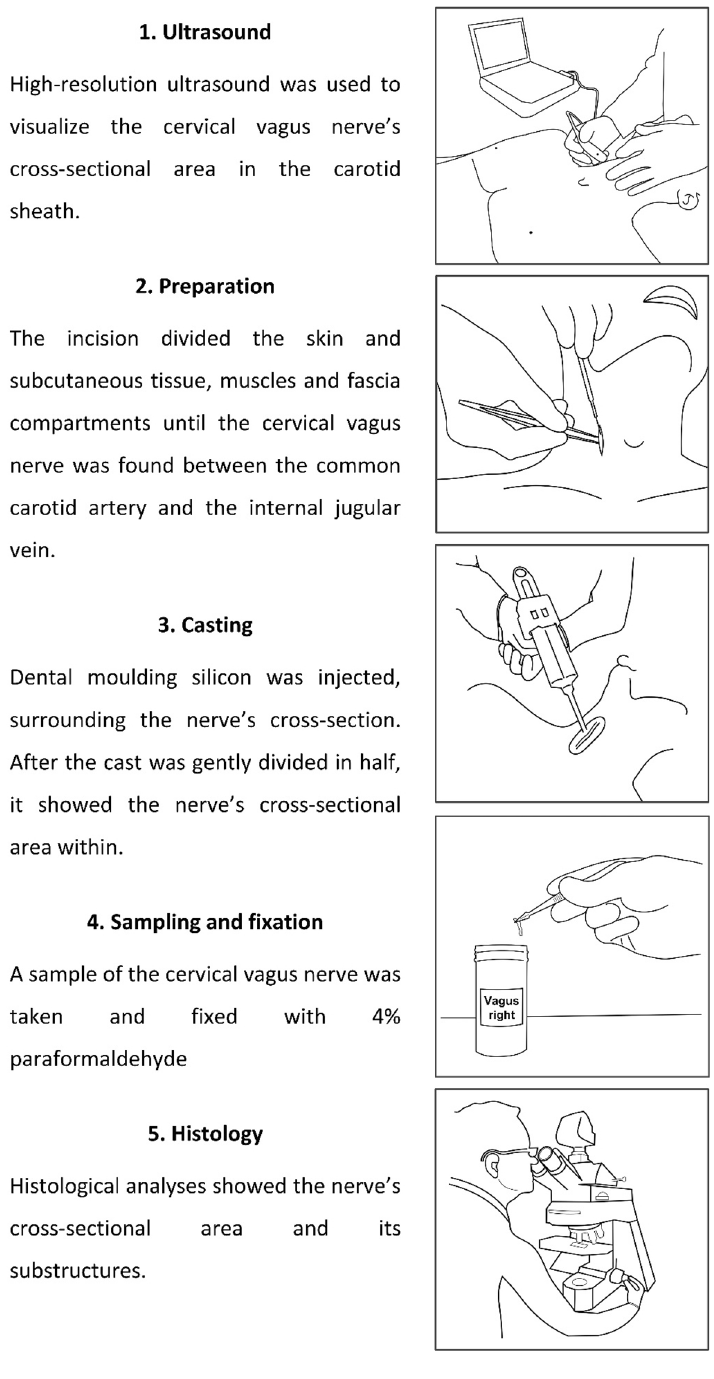
Figure 6. Five steps showing the workflow of analyzing the cervical vagus nerve’s cross-sectional